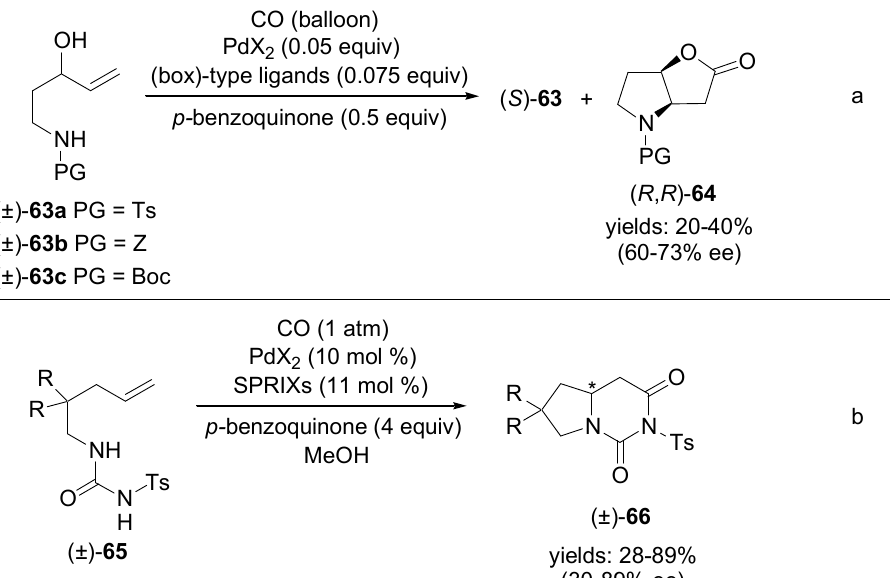
Scheme 25. Kinetic resolution of N -protected 1-aminopent-4-ene-3-ols (±) -63 in the Pd(II)-catalysed amidocarbonylation and Pd(II)-catalysed amidocarbonylation of alkenylureas 65